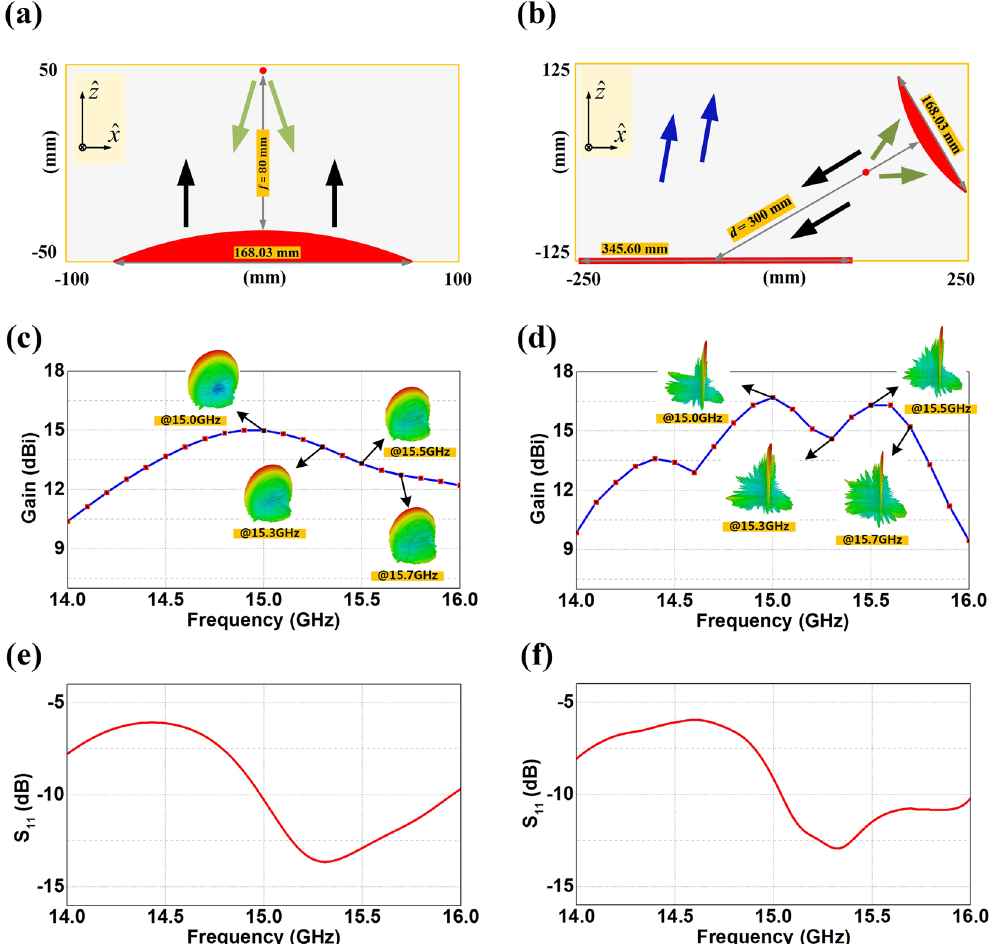
Figure 6. Configurations and the radiation performances of the optimized convex meta-mirror and the dual reflecting system. ( a ) The optimized convex meta-mirror. ( b ) The optimized dual reflecting system. ( c ) The gains of the optimized convex meta-mirror from 14 GHz to 16 GHz. ( d ) The gains of the optimized dual reflecting system from 14 GHz to 16 GHz. ( e ) The reflection coefficients of the optimized convex meta-mirror from 14 GHz to 16 GHz. ( f ) The reflection coefficients of the optimized dual reflecting system from 14 GHz to 16